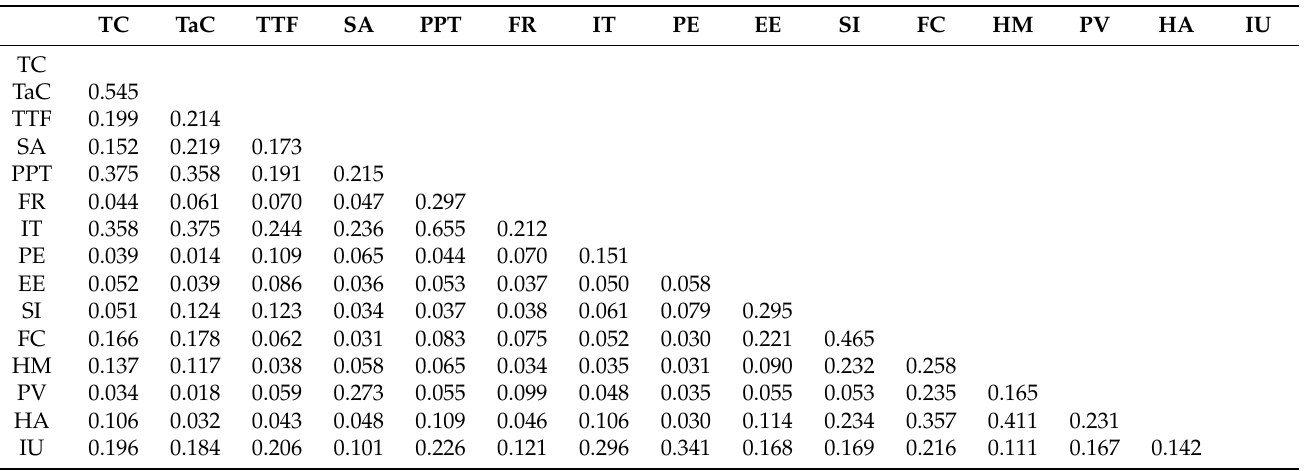
Table 5. Heterotrait-Monotrait Ratio (HTMT).